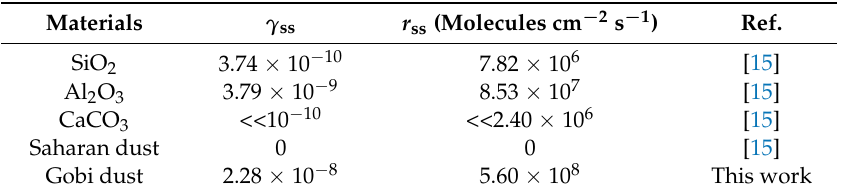
Table 1. Comparison of γ ss and r ss determined in the presence of 100 ppb of ozone on natural Gobi dust, SiO 2 , Al 2 O 3 and CaCO 3 under atmospheric pressure and at room temperature.